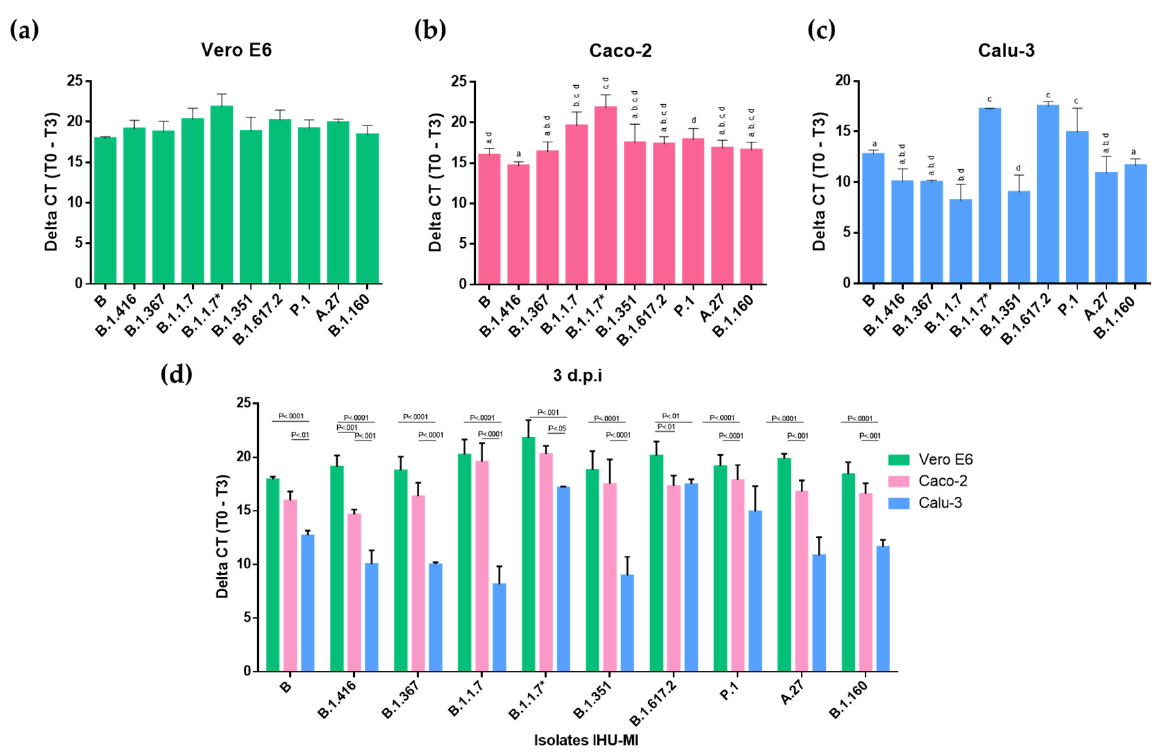
Figure 2. Replication levels of different SARS-CoV-2 lineages in three distinct cell lines. The replication levels of the SARS-CoV-2 lineages (PANGO) are expressed in delta CT (cycle threshold), three days post-infection, in three distinct cell lines: ( a ) Vero E6, ( b ) Caco-2, and ( c ) Calu-3. The values with different superscript letters in a column are significantly different ( p < 0.05). ( d ) Comparison of the replication of a SARS-CoV-2 isolate from each viral lineage inoculated on different cells: Vero E6 (Green), Caco-2 (Pink) and Calu-3